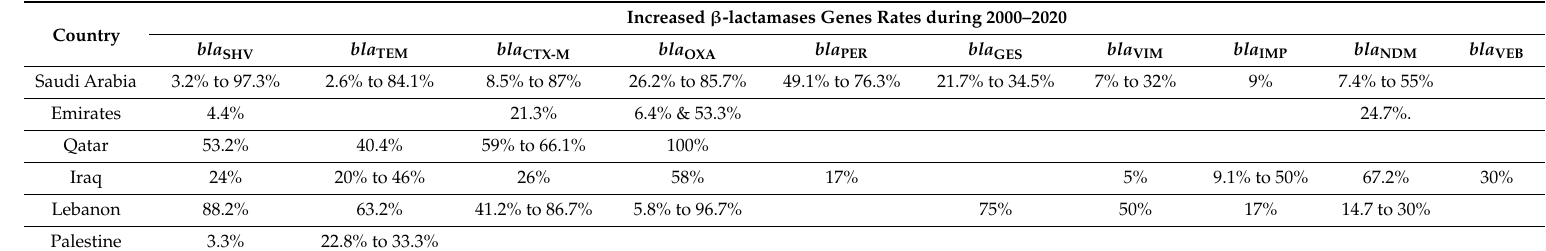
Table 2. Increased prevalence for the β -lactamases genes in E. coli and ESKAPE pathogens in Arabian region for the years